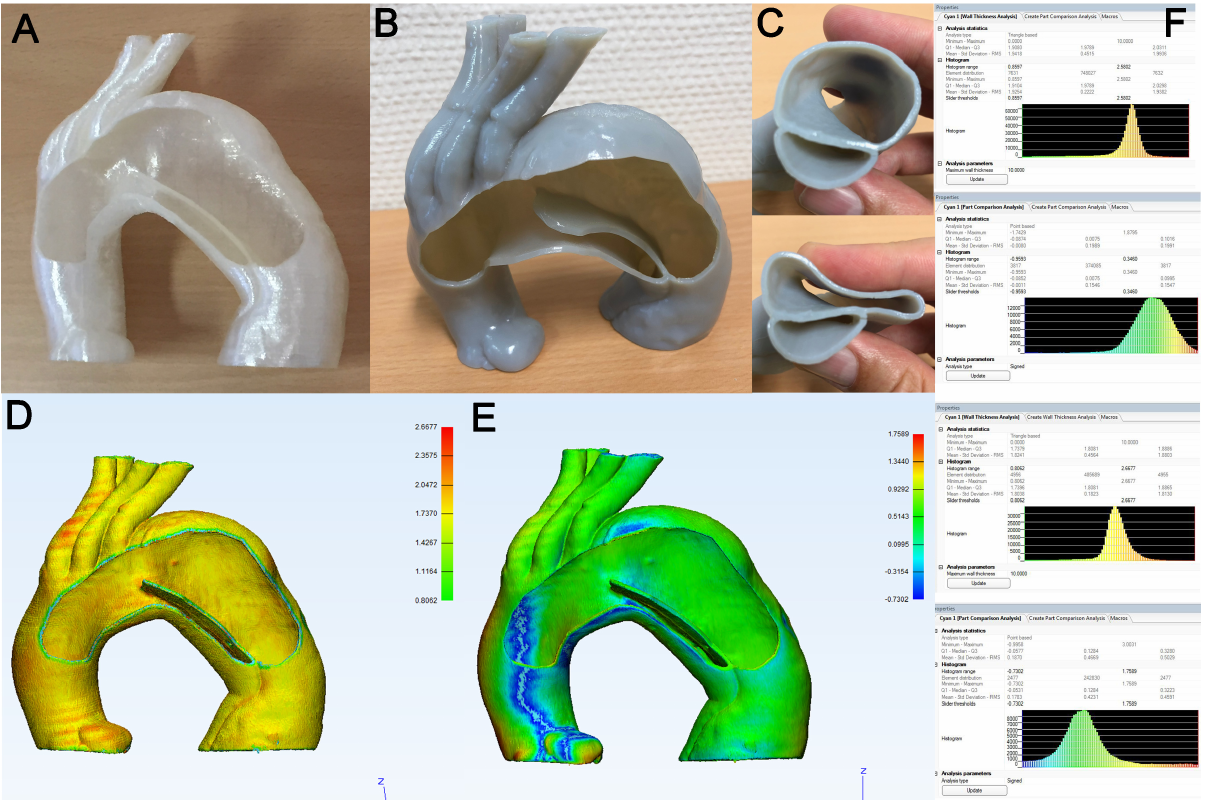
Figure 7. Representative examination of 3D model of aortic dissection. ( A ): 3D model generated in FDM printing (rigid PLA). ( B ): 3D model generated in PolyJet printing (flexible polymer, Stratasys Tango ® gray). ( C ): Flexibility of the model is shown by digital compression. ( D ): Color map of WTA. ( E ): Color map of PCA. ( F ): Histogram results of WTA (upper panel) and PCA (upper middle panel) for model A, and histogram results of WTA (lower middle panel) and PCA (lower panel) for model